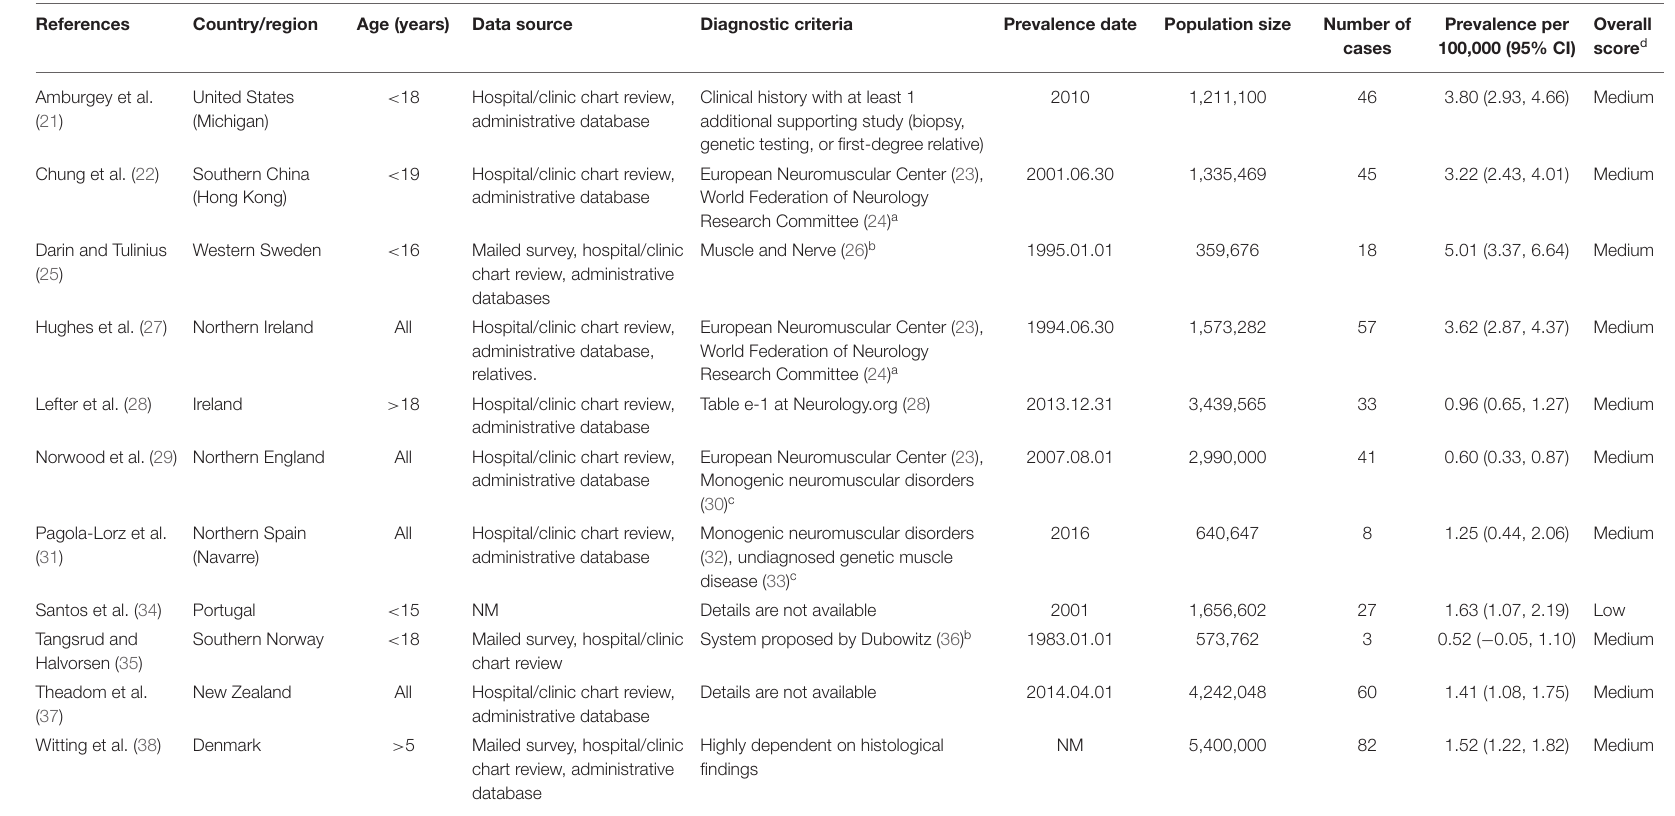
TABLE 1 | Characteristics of the included studies on congenital myopathy